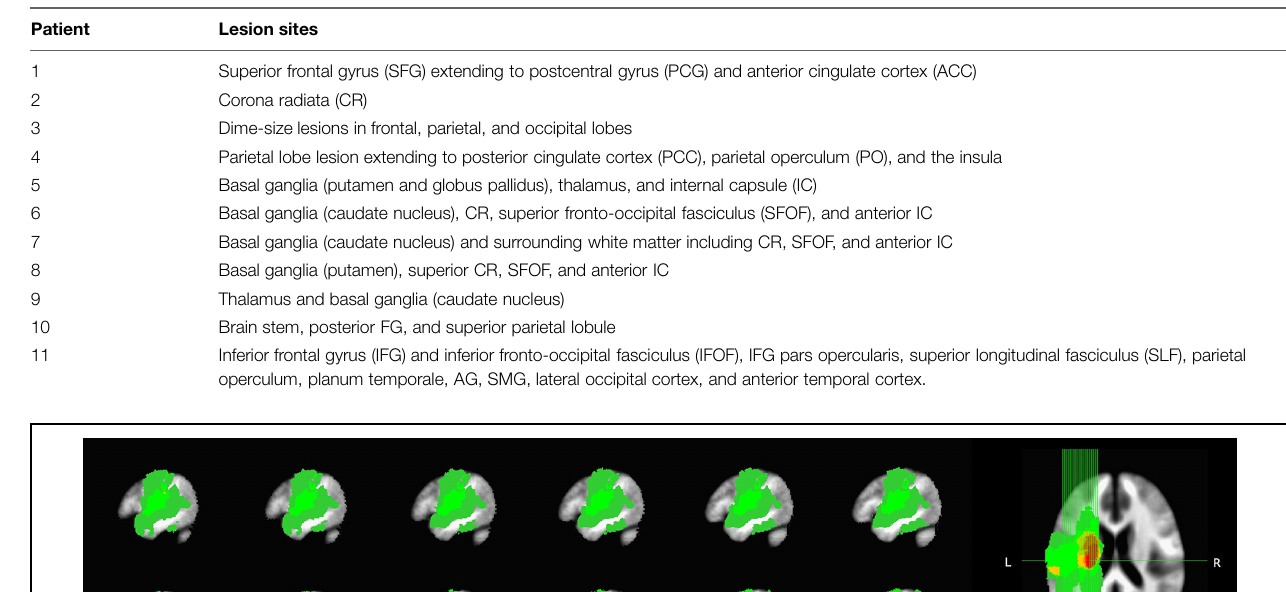
TABLE 4 | The left-sided lesion locations identified for each patient.